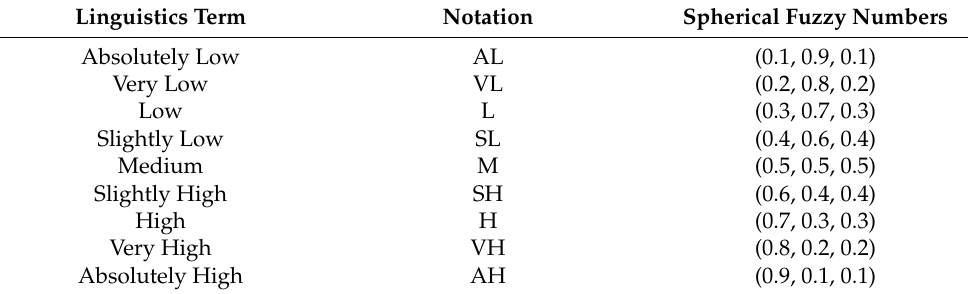
Table 3. Linguistics term and respective SFNs for the SF EDAS